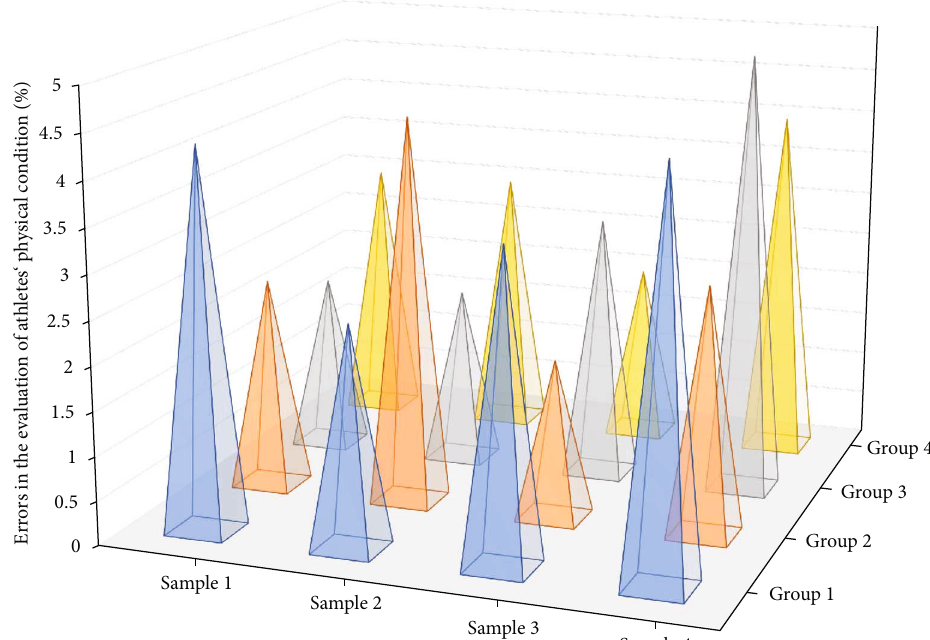
Figure 7: Comparison of evaluation errors of athletes ’ physical fi tness.